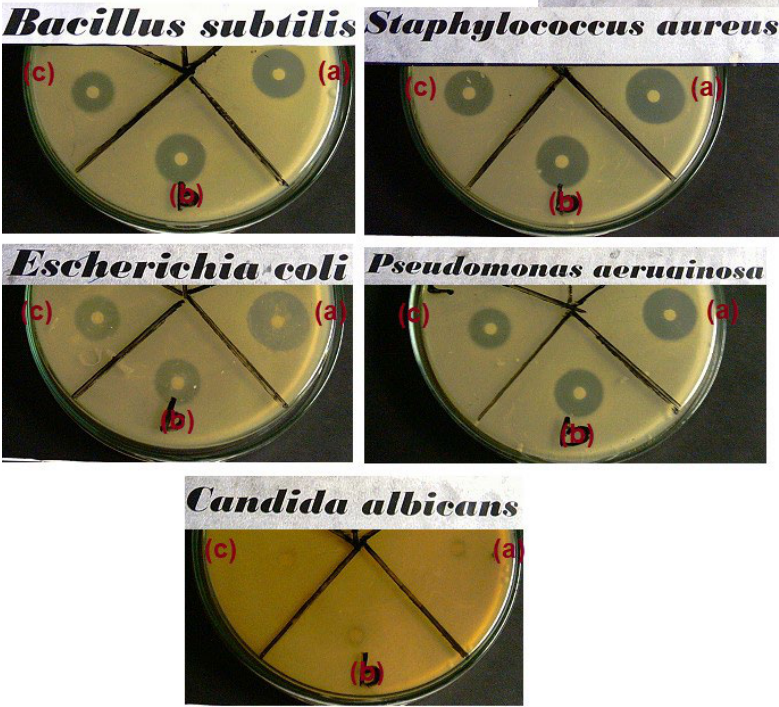
Figure 9. Antimicrobial activity for TiO 2 ( a ), NC20–TiO 2 ( b ), and NC80–TiO 2 ( c ) nanocomposites.